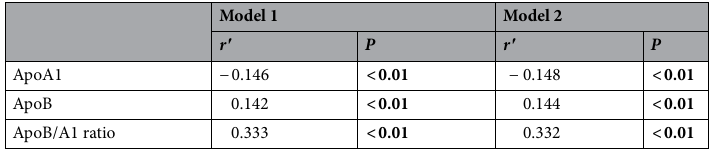
Table 2. Relationships between serum apolipoprotein levels and HbA1c a . Abbreviations were shown in Table 1. a Partial correlation analysis, Model 1 adjusted for age and gender. Model 2 adjusted for age, gender,